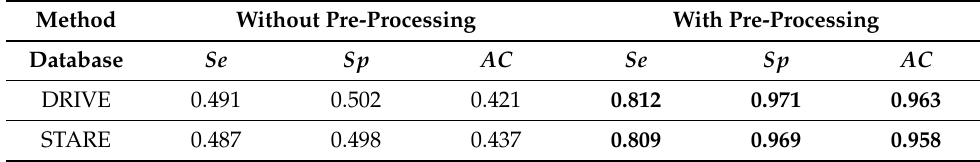
Table 2. Effectiveness of Pre-processing